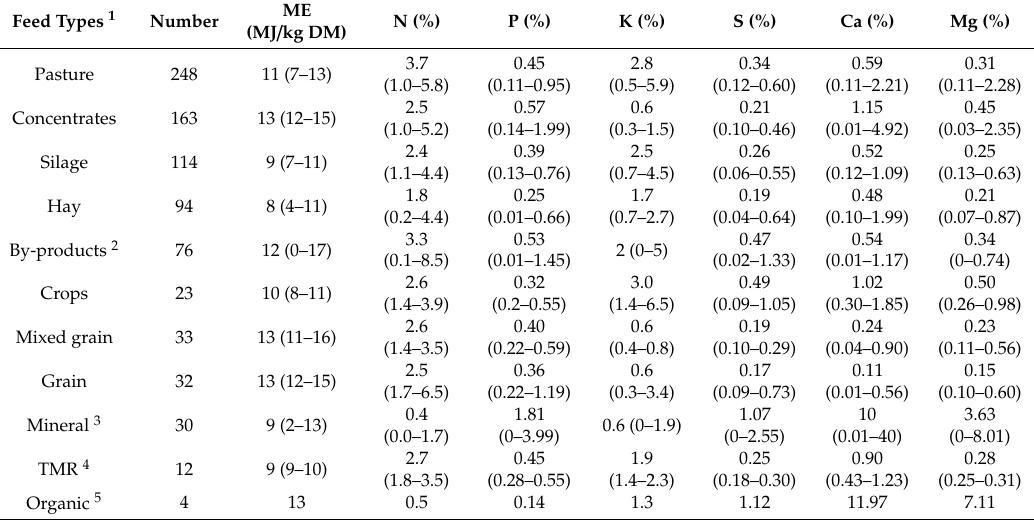
Table 3. Mean nutrient (minimum-maximum) concentrations in samples of feeds (pasture and supplements) consumed by grazing herds on five occasions on 43 dairy